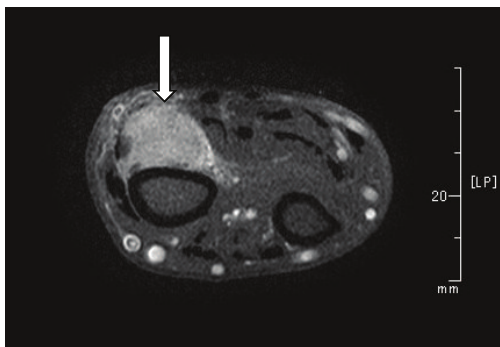
Figure 2: Gadolinium enhanced MRI image of the patient’s right wrist. White arrow indicates the